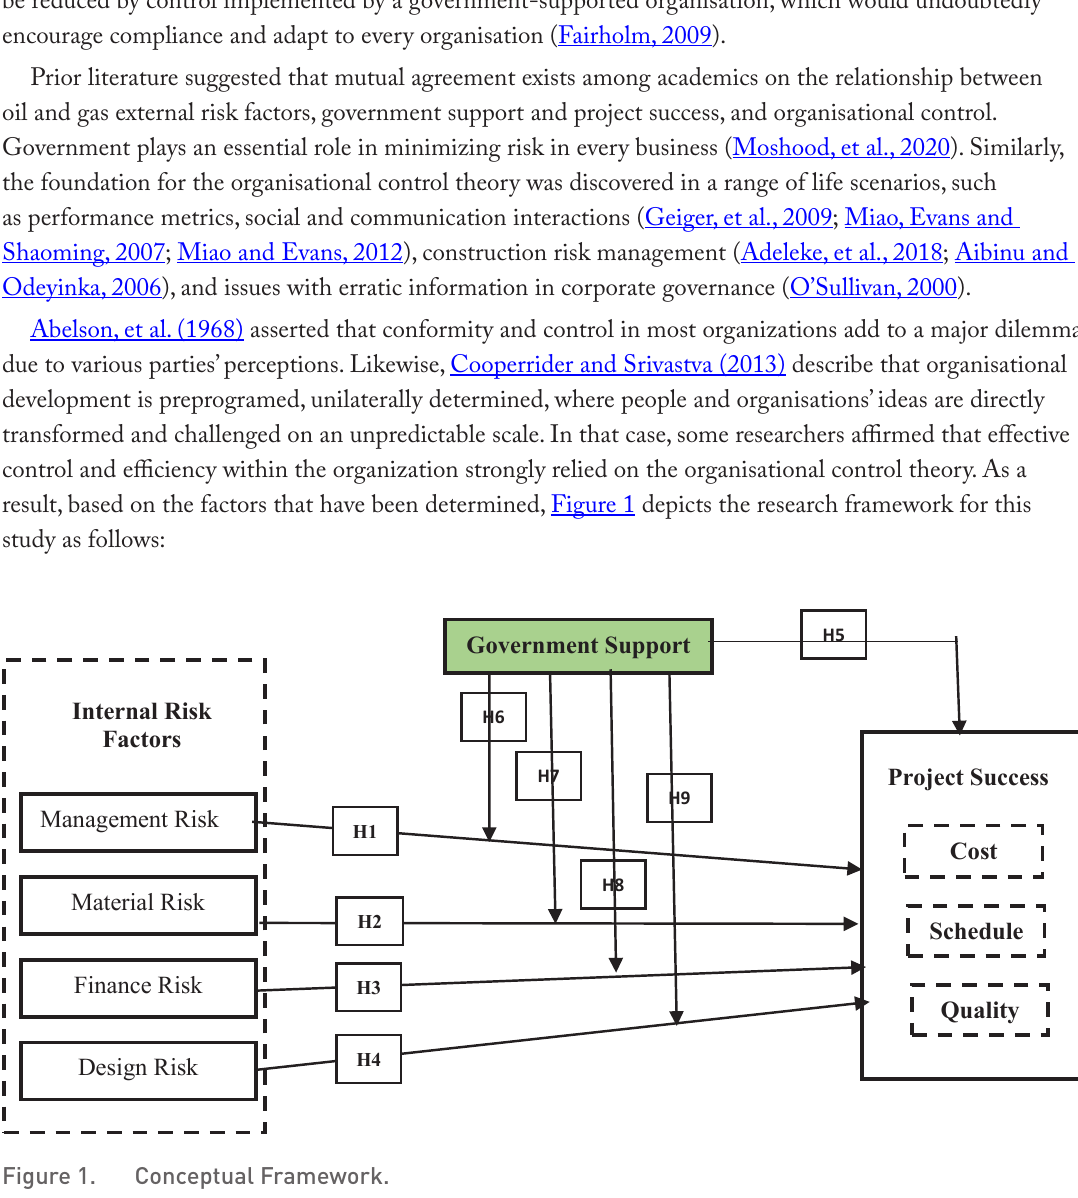
Figure 1. Conceptual